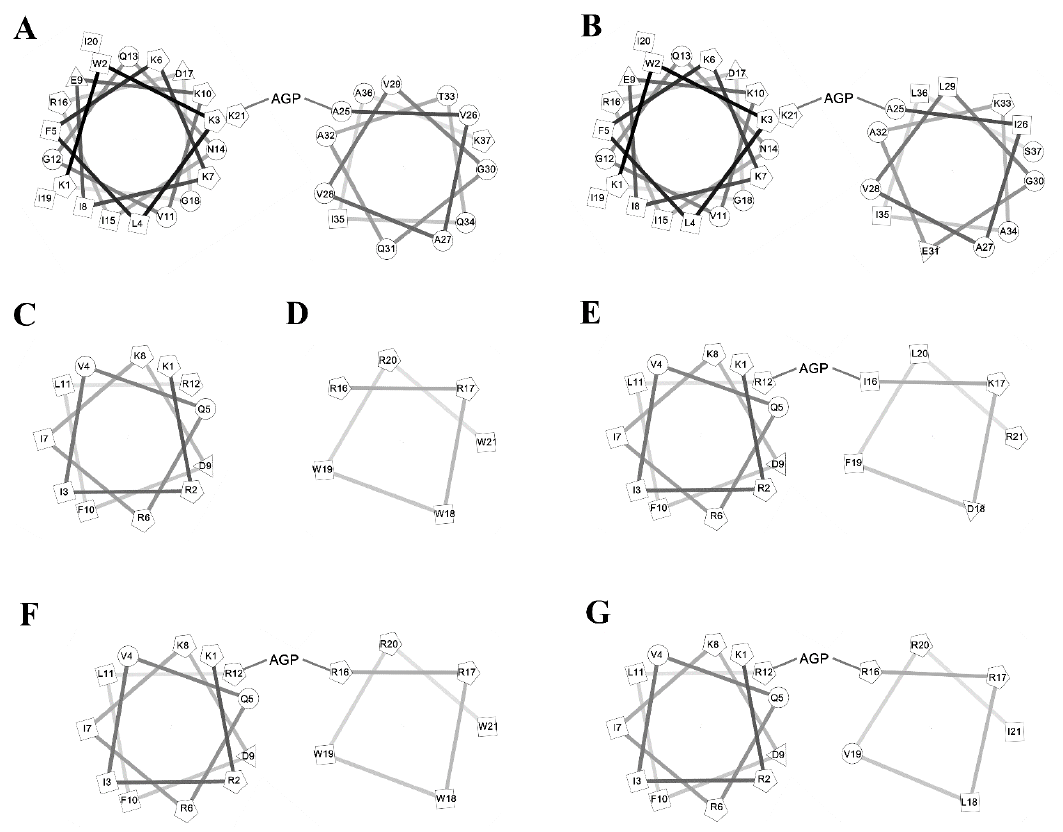
Figure 1. Helical wheel of the peptides. ( A ) cecropin A, ( B ) cecropin B, ( C ) KR12, ( D ) RW6, ( E ) KR12AGPKR6, ( F ) KR12AGPWR6, ( G ) KR12AGPVR6.